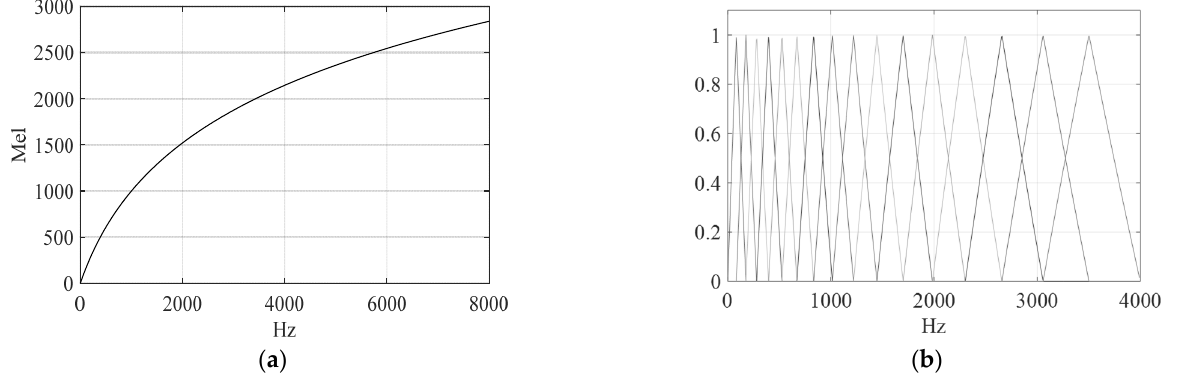
Figure 2. A mapping from hertz to Mel scale ( a ) and 16 Mel FBs for a 0–8 kHz frequency range ( b